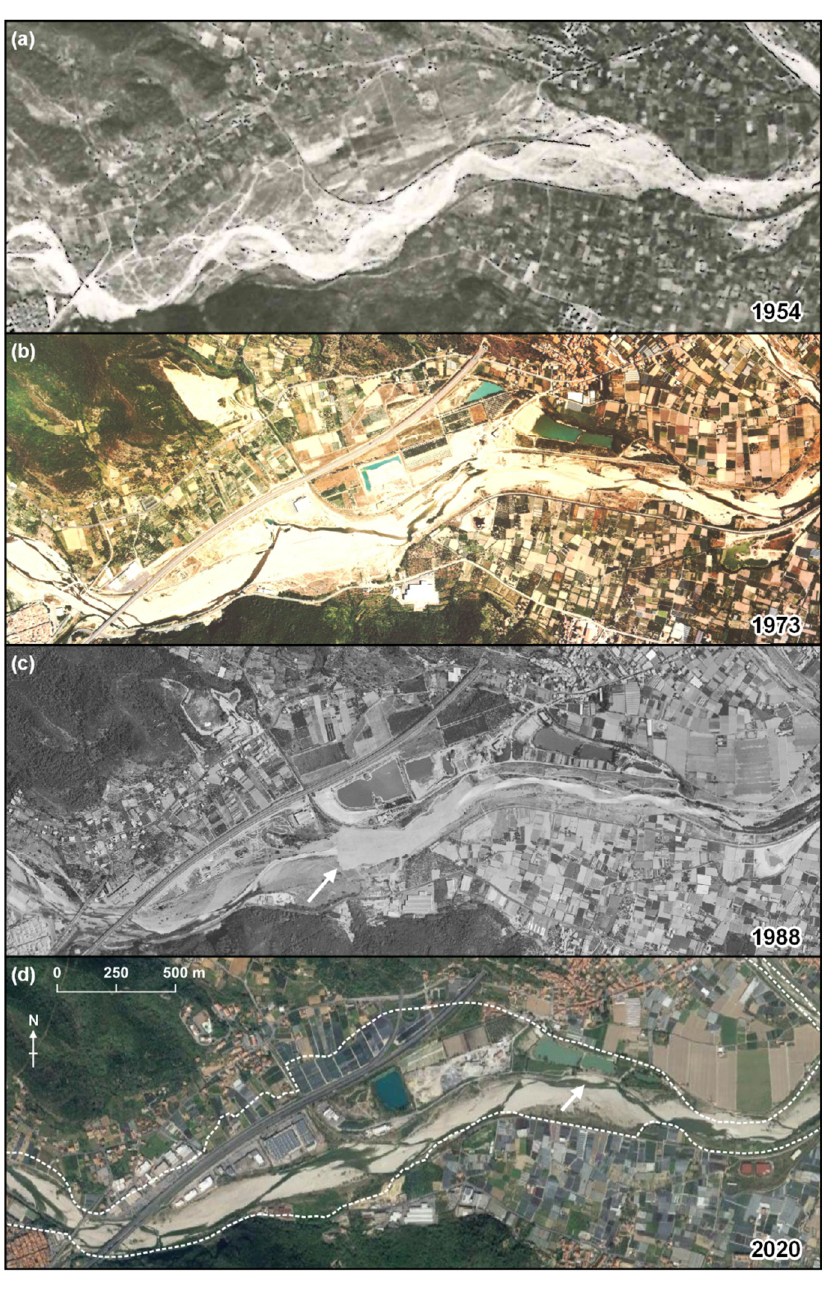
Figure 14. LULC evolution in reach A3: ( a ) 1954, ( b ) 1973, ( c ) 1988, ( d ) 2020. The flow is from left to right. The progressive occupation by human activities and structures of the left side of the valley floor is evident. The white arrow in ( c ) indicates an approximatively 500 m long reach where active-channel forms were obliterated by bulldozers. The white arrow in ( d ) pinpoints the after-2016 bank retreat process that involved some areas out of the macrochannel. The white dotted line in ( d ) represents the active channel in 1930.